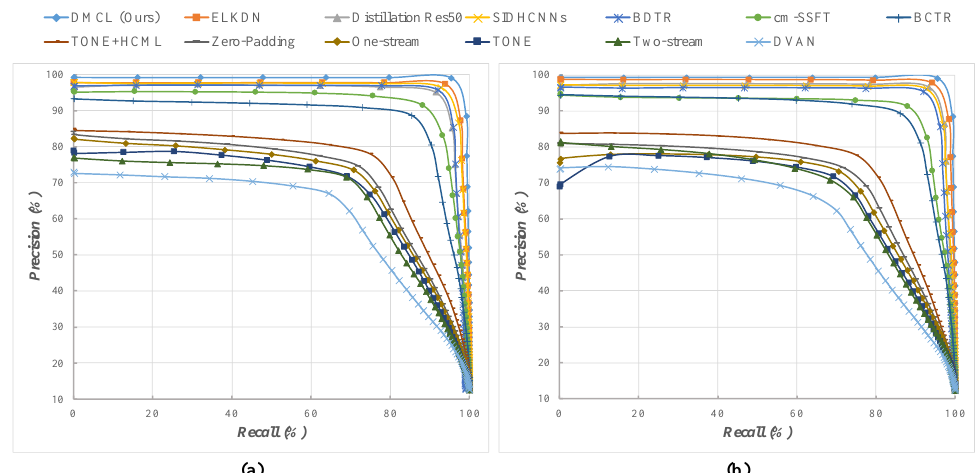
Figure 4. Comparisons of precision–recall curve of different methods.( a ) Comparisons of different methods in MUL → PAN task. ( b ) Comparisons of different methods in PAN → MUL